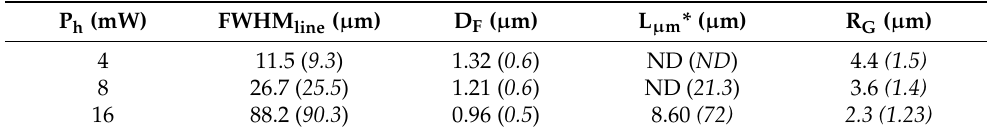
Table 1. Theoretical performances of the LFRB system based on PDMS/SLG interface. Objective focal length: 2.6 mm. Probe wavelengths: 633 nm ( 405 nm).